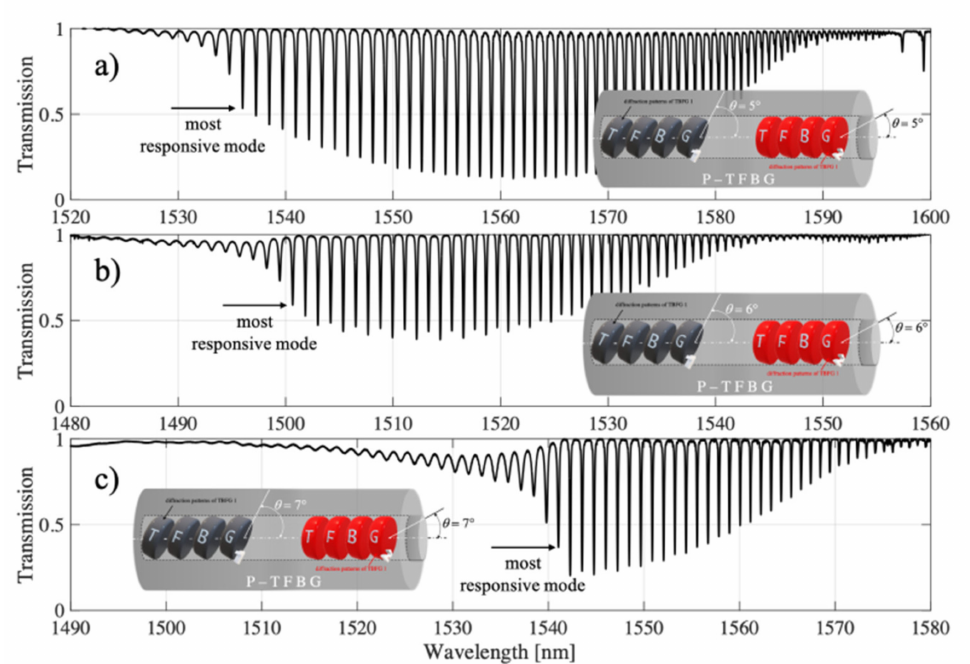
Figure 17. Spectral characteristics of the P-TFBG system for variable inclination angles of TFBG structures of: ( a ) 5 ◦ , ( b ) 6 ◦ , ( c ) 7 ◦